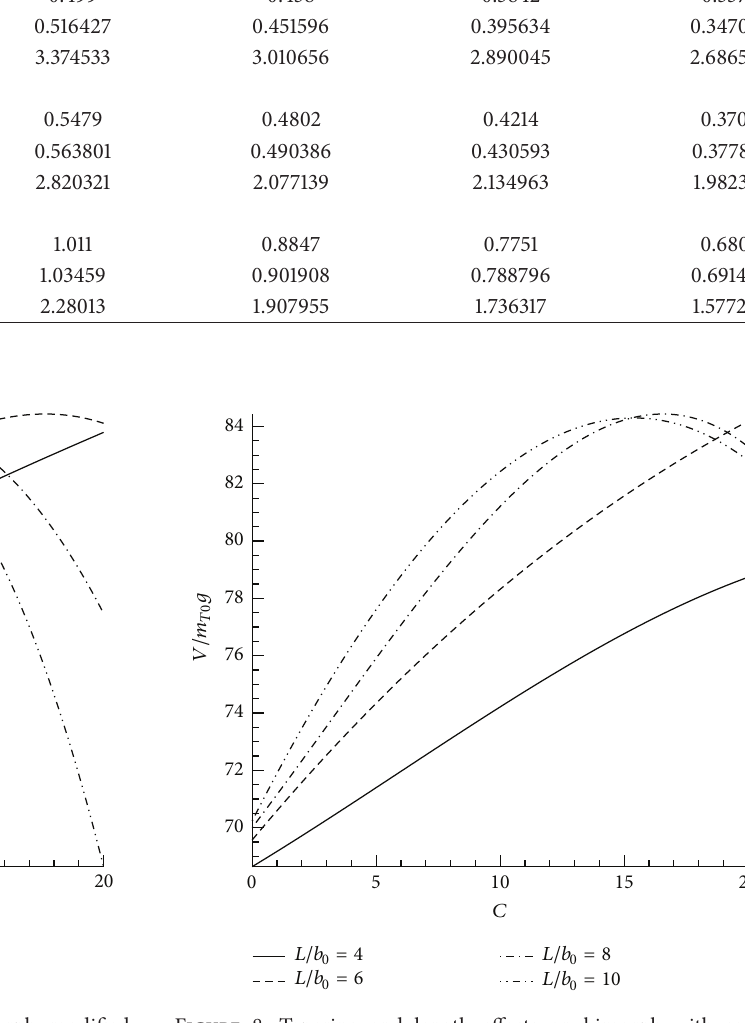
Figure 8: Tapering and length effects on bimorph with series connection, modified